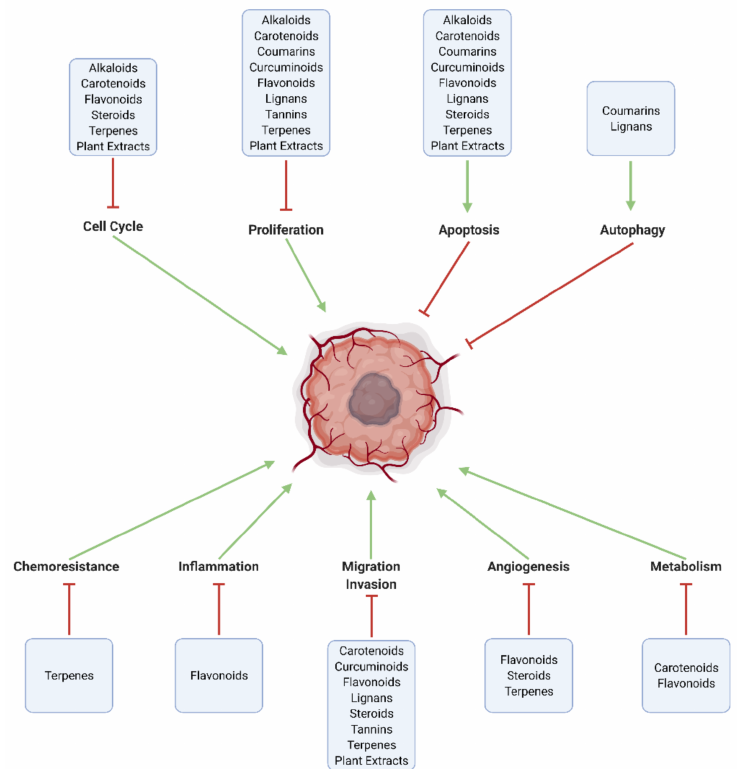
Figure 3. Major pathways modulated by natural substances in GBM. Effective chemotherapeutic substances increase cell death through apoptosis and autophagy, and inhibit intracellular mechanisms related to proliferation, cell cycle progression, tumor metabolism (Warburg effect), angiogenesis, invasion and metastasis, neuroinflammation, and